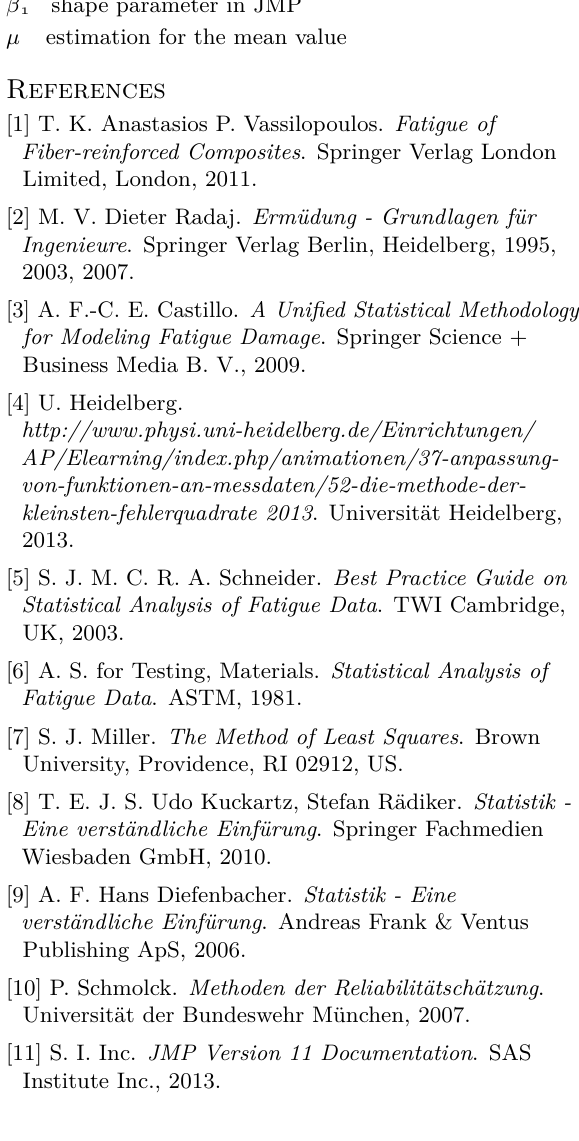
Figure 10. Custom estimate for Material#1.